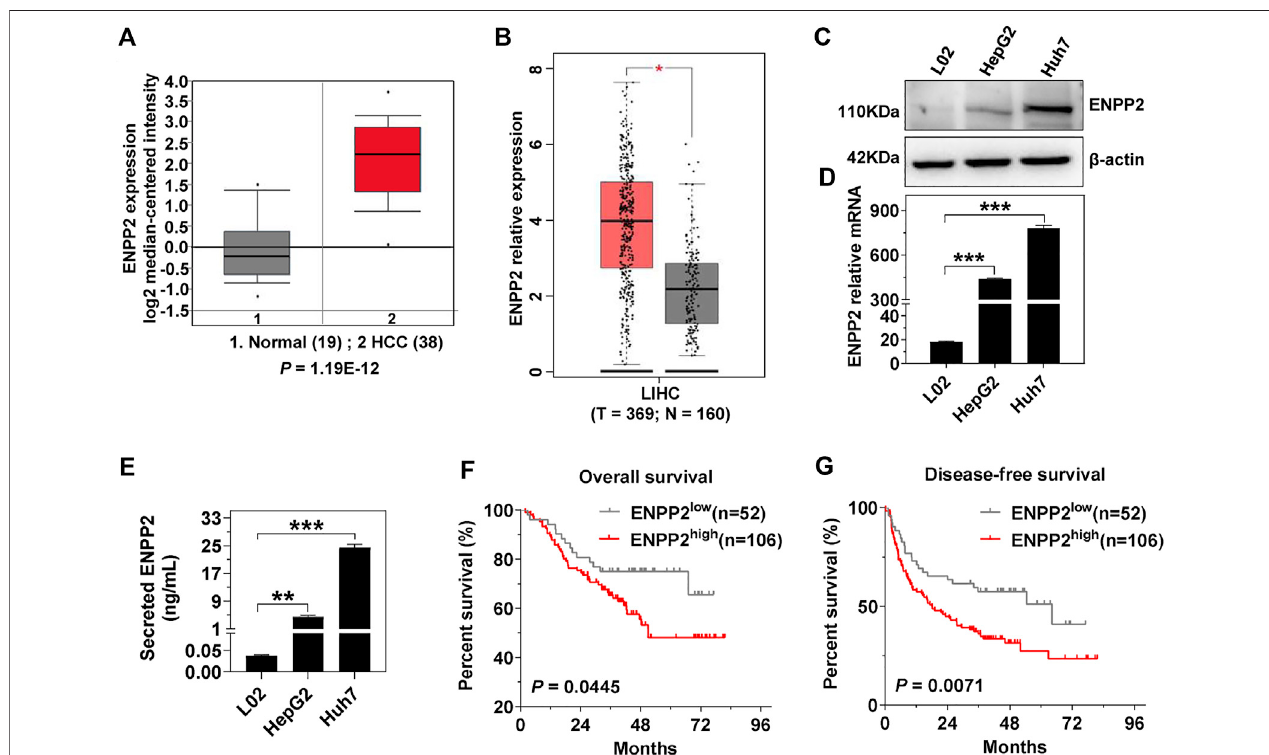
FIGURE 1 | ENPP2 expression is positively correlated with poor patient prognosis. (A) Oncomine database analysis of the ENPP2 median-centered intensity in normal (n (cid:1) 19) and HCC tissue (n (cid:1) 38). (B) GEPIA database analysis of the relative mRNA expression of enpp2 in matched HCC tissues (n (cid:1) 369) and adjacent normal tissues (n (cid:1) 160). (C) The intracellular ENPP2 protein expression in L02, HepG2, and Huh7, respectively. (D) The level of enpp2 mRNA in L02, HepG2, and Huh7, respectively. (E) The secreted ENPP2 in supernatants from L02, HepG2, and Huh7, respectively. (F, G) Overall survival (F) and disease-free survival (G) for ENPP2 high (n (cid:1) 106) and ENPP2 low (n (cid:1) 52) expression patients, respectively. The statistical analysis was based on three independent experiments. *, p < 0.05; **, p < 0.01; ***, p <